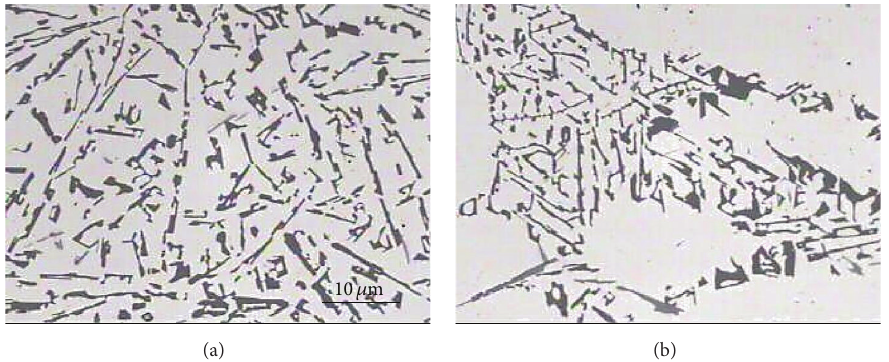
Figure 9: Size and distribution of eutectic Si particles in (a) T9 and (b) T9S 356 alloys.